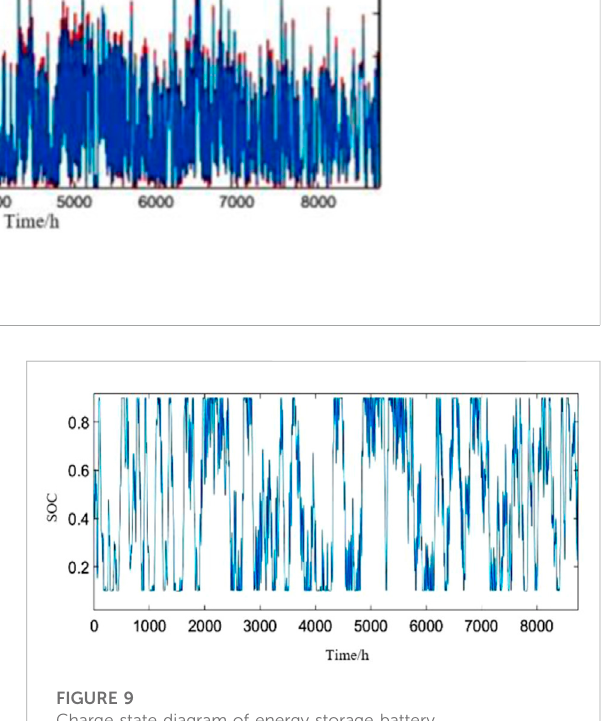
FIGURE 9 Charge state diagram of energy storage